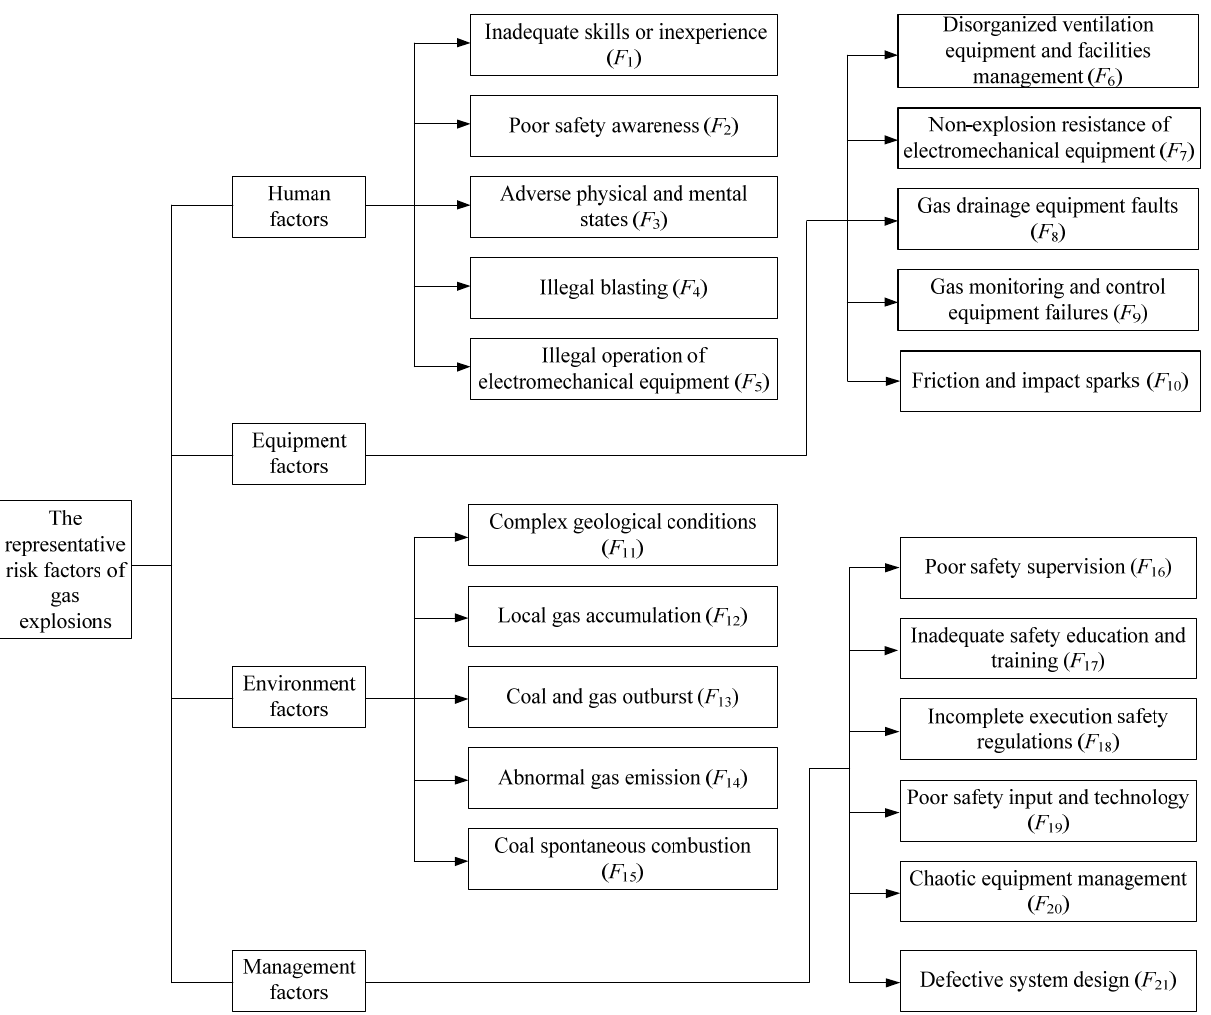
Figure 1. Index system of the representative risk factors of gas explosions.